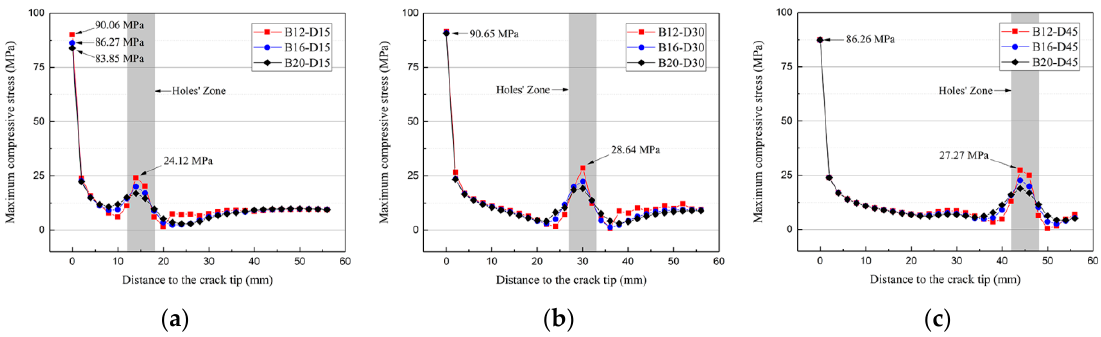
Figure 15. Numerical (AUTODYN) results of maximum compressive stress curves. ( a ) Specimens with a constant distance of D = 15 mm. ( b ) Specimens with a constant distance of D = 30 mm. ( c ) Specimens with a constant distance of D = 45 mm.